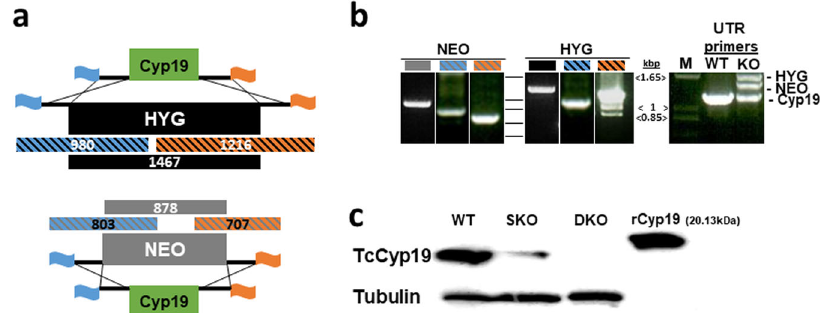
Fig. 1 DNA and protein analysis of Cyp19 knock-out parasites. a Strategy of Cyp19 gene knock-out using double allelic replacement with genes for neomycin phosphotransferase (NEO) and hygromycin phosphotransferase (HYG) genes. Predicted PCR fragment sizes as indicated (in bps). Right and left chromosomal fl anking regions depicted by orange and blue fl ags. b PCR analysis of NEO and HYG integration of puri fi ed chromosomal parasite DNA showing each pair of primers. 5 ′ - and 3 ′ -UTR primers were used to con fi rm presence of NEO and HYG gene integration, but also identi fi ed presence of a 3rd copy of Cyp19 (far right panel). c Western blot analysis for Cyp19 protein in wild type (WT) SKO-NEO (SKO) and DKO cells. α -tubulin analysis was performed in duplicate blots as a loading control for each cell line (as shown). rCyp19 is puri fi ed His-tagged Cyp19, as a control. Source data for PCR and western blotting is found in Supplementary Figs. 14 and